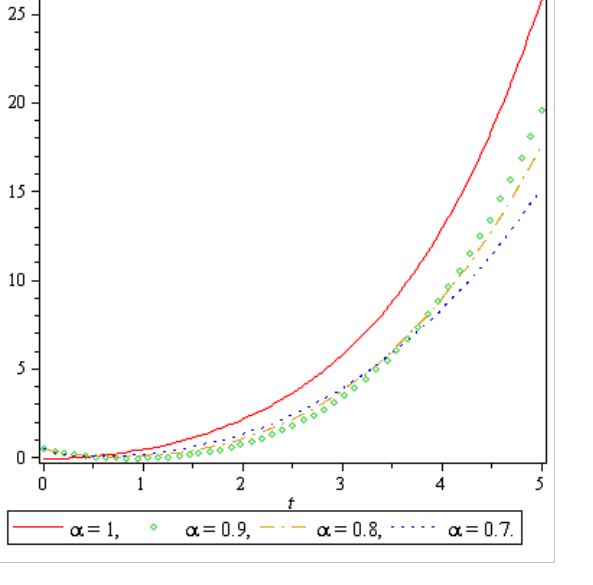
Fig. 2: Fourth order approximation q -FHATM solution c verses time t for Eq. (22) at x = 0.5, k = w = 0.8 and different values of α .